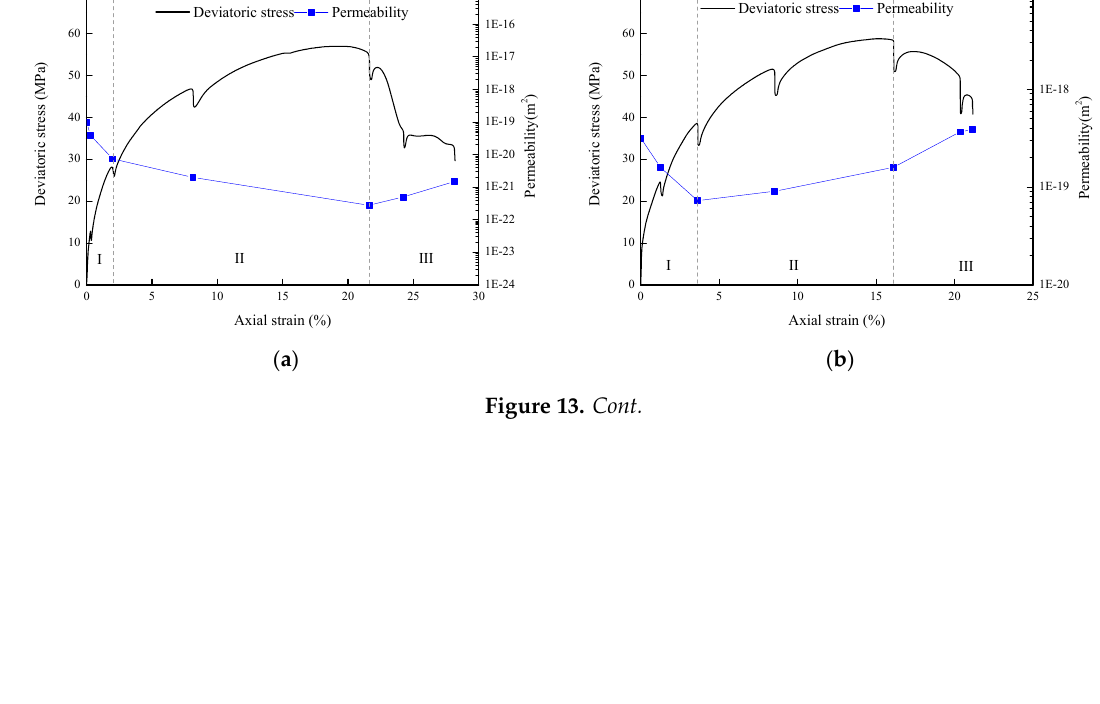
Figure 12. Permeability evolution of the pure salt rock under a different confining pressure.